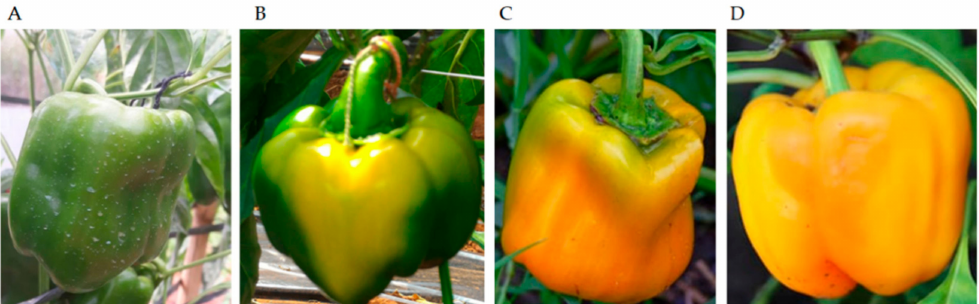
Figure 3. Visual aspects of sweet pepper fruit at 35 ( A ), 50 ( B ), 65 ( C ) and 80 ( D ) days after